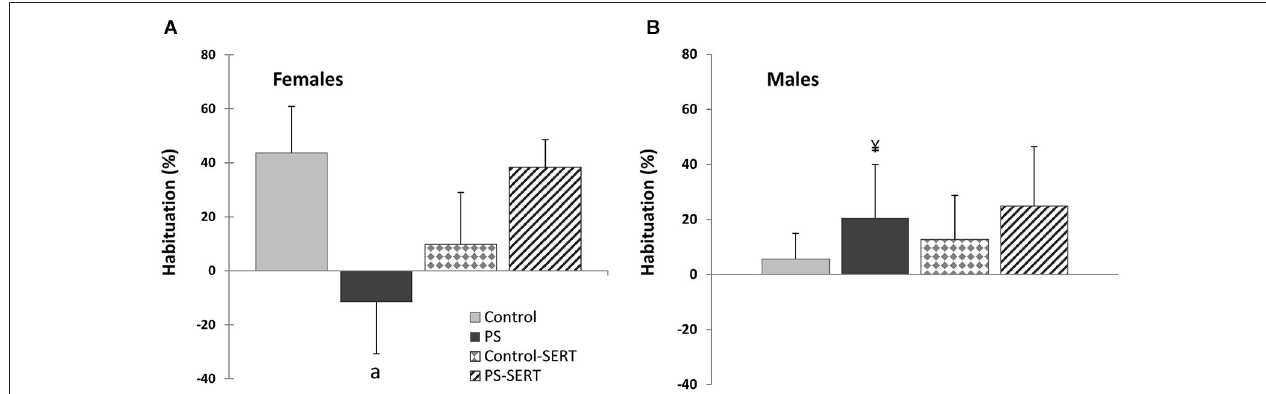
FIGURE 3 | Effects of prenatal stress and SERT treatment (5 mg/kg/day) on habituation (percentage) in females (A) and males (B) at P90 . a, p < 0.05, indicates a main effect of prenatal stress; (cid:85) , p < 0.05, indicates a main effect of sex. Means ± standard error.